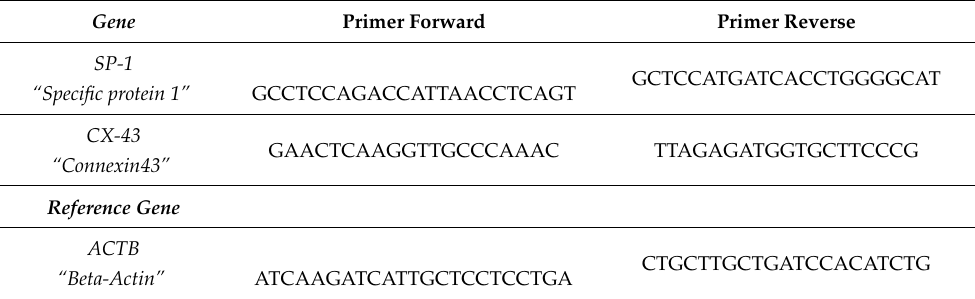
Table 2. List of gene primers used to study gene expression profiling. Their expression was normal- ized to the b-actin housekeeping